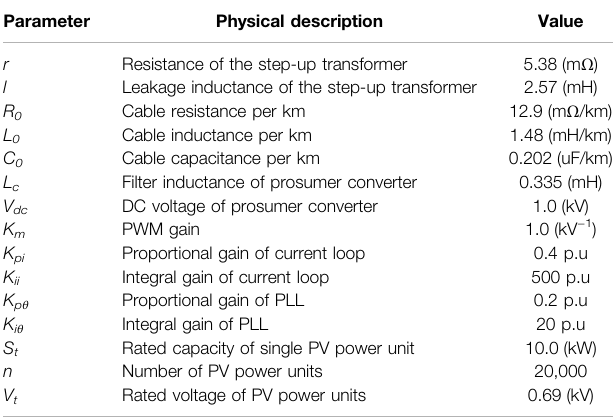
A schematic diagram of the study system is depicted in Figure 2 .